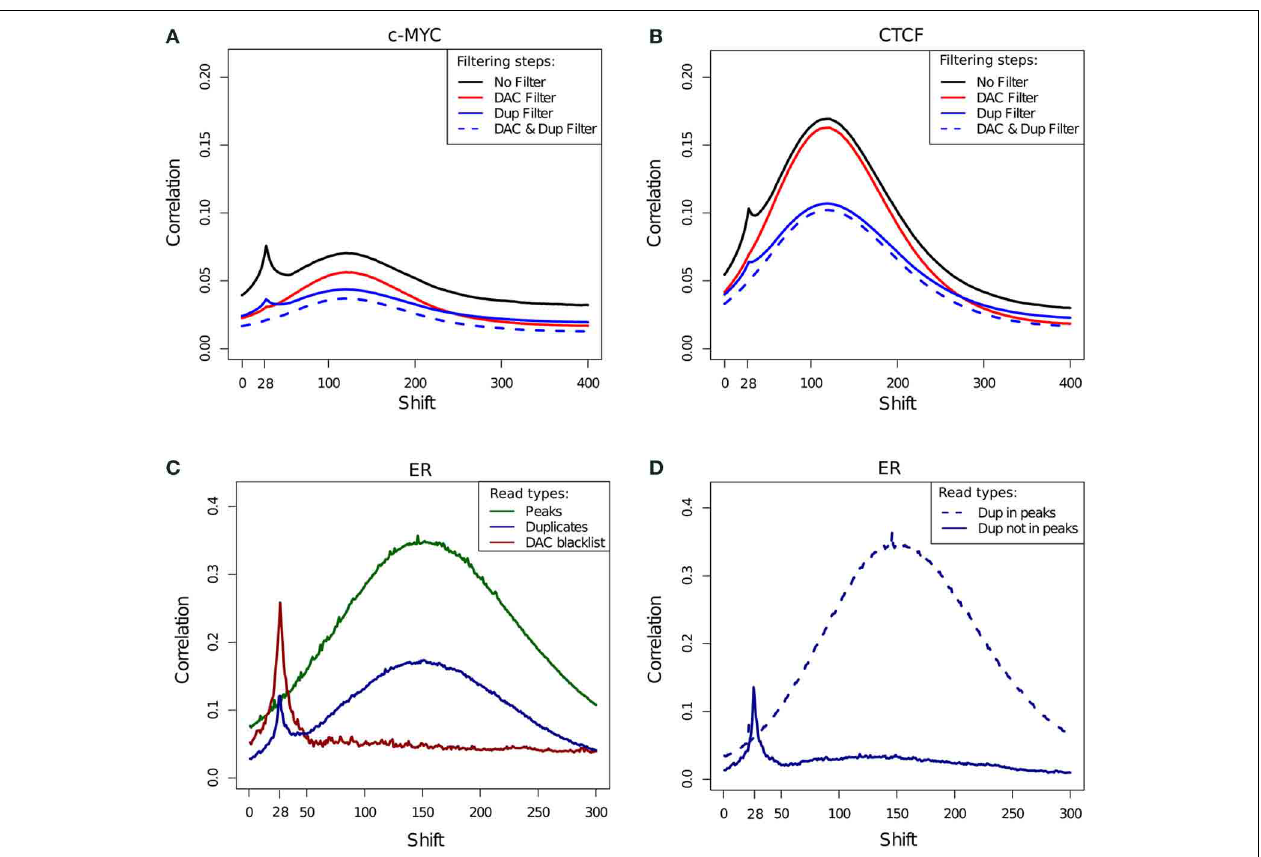
FIGURE 7 | (A,B) Examplecross-correlationprofilesforac-Myc (A) andaCTCF (B) sample (SRR568130 and SRR568129, respectively). Cross-correlation profiles after no filtering, filtering of duplicated reads, exclusion of DAC consensus blacklist and simultaneous blacklisting and duplicate removal. (C)